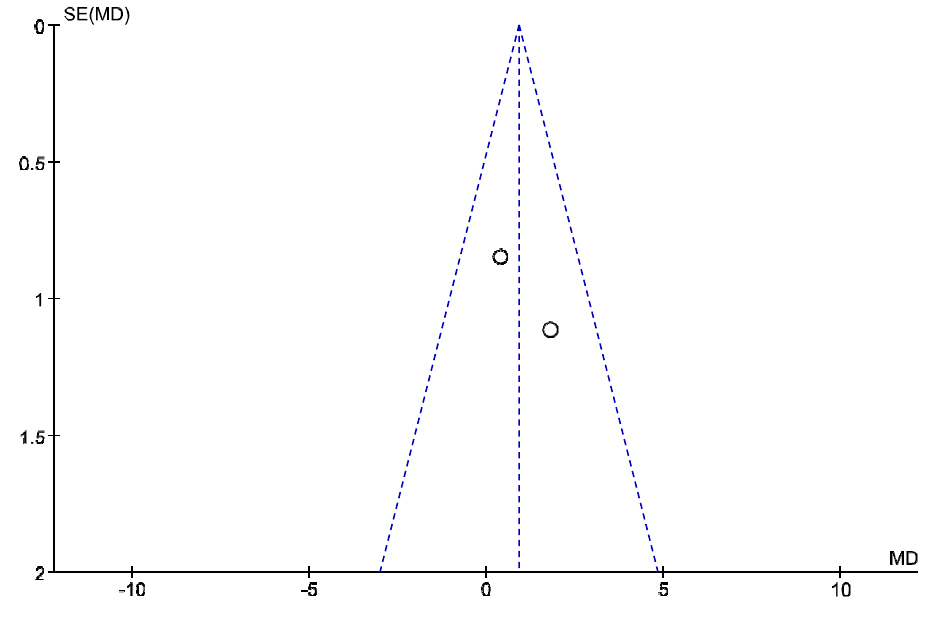
Figure 24. Phonophoresis for